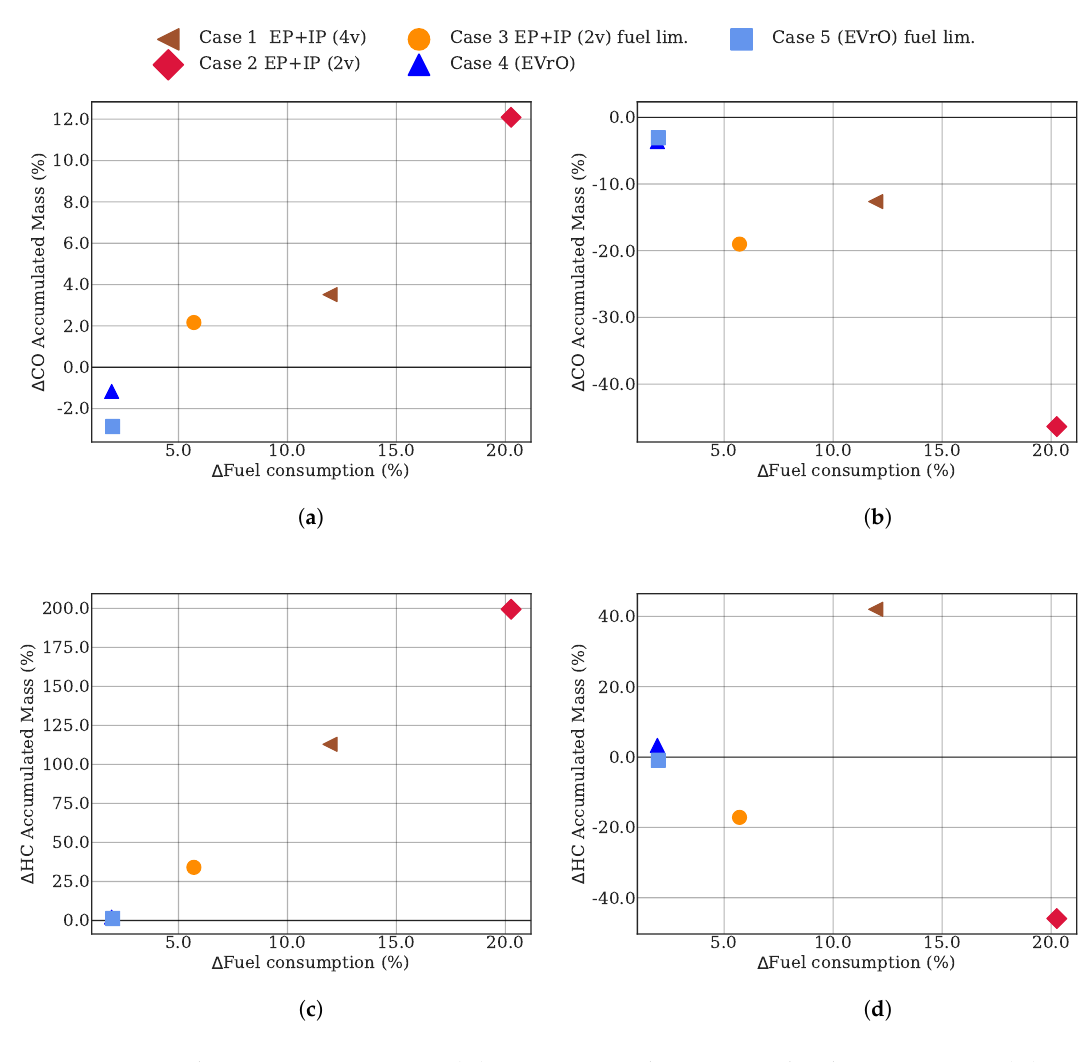
Figure 16. Fuel consumption variation (%) versus CO and HC accumulated mass variation (%) trade-offs during the low speed stage of the WLTC, taking the baseline case as the reference. ( a ) Fuel consumption (%) versus CO accumulated mass (%) upstream the DOC. ( b ) Fuel consumption (%) versus CO accumulated mass (%) downstream the DOC. ( c ) Fuel consumption (%) versus HC accumulated mass (%) upstream the DOC. ( d ) Fuel consumption (%) versus HC accumulated mass (%) downstream the